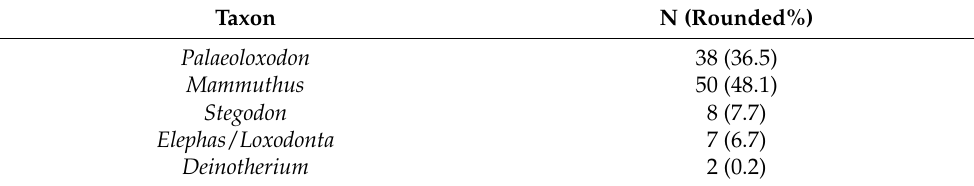
Table 3. The percentages of sites in Table 1 for which proboscidean genera were identified ( n = 104).